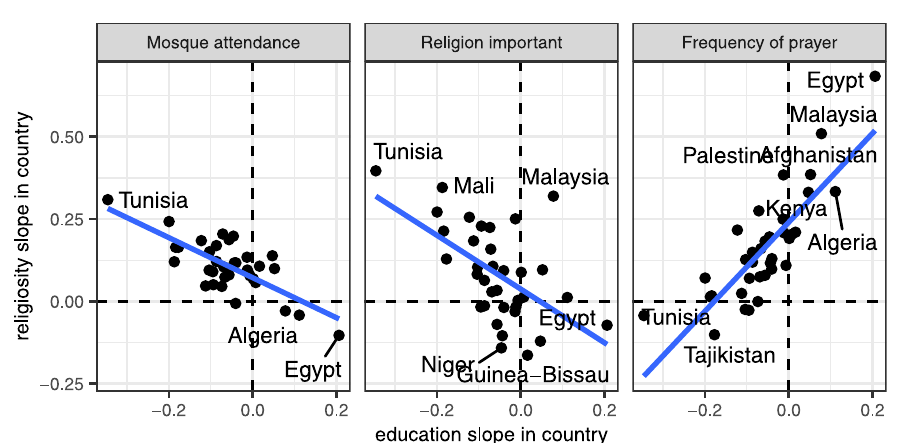
Fig 5. Scatterplot showing the relationship between country-level associations of education and religiosity with support for violent practices. Values based on random slopes from Model 3 of Table 1. Best-fitting OLS line is shown in each